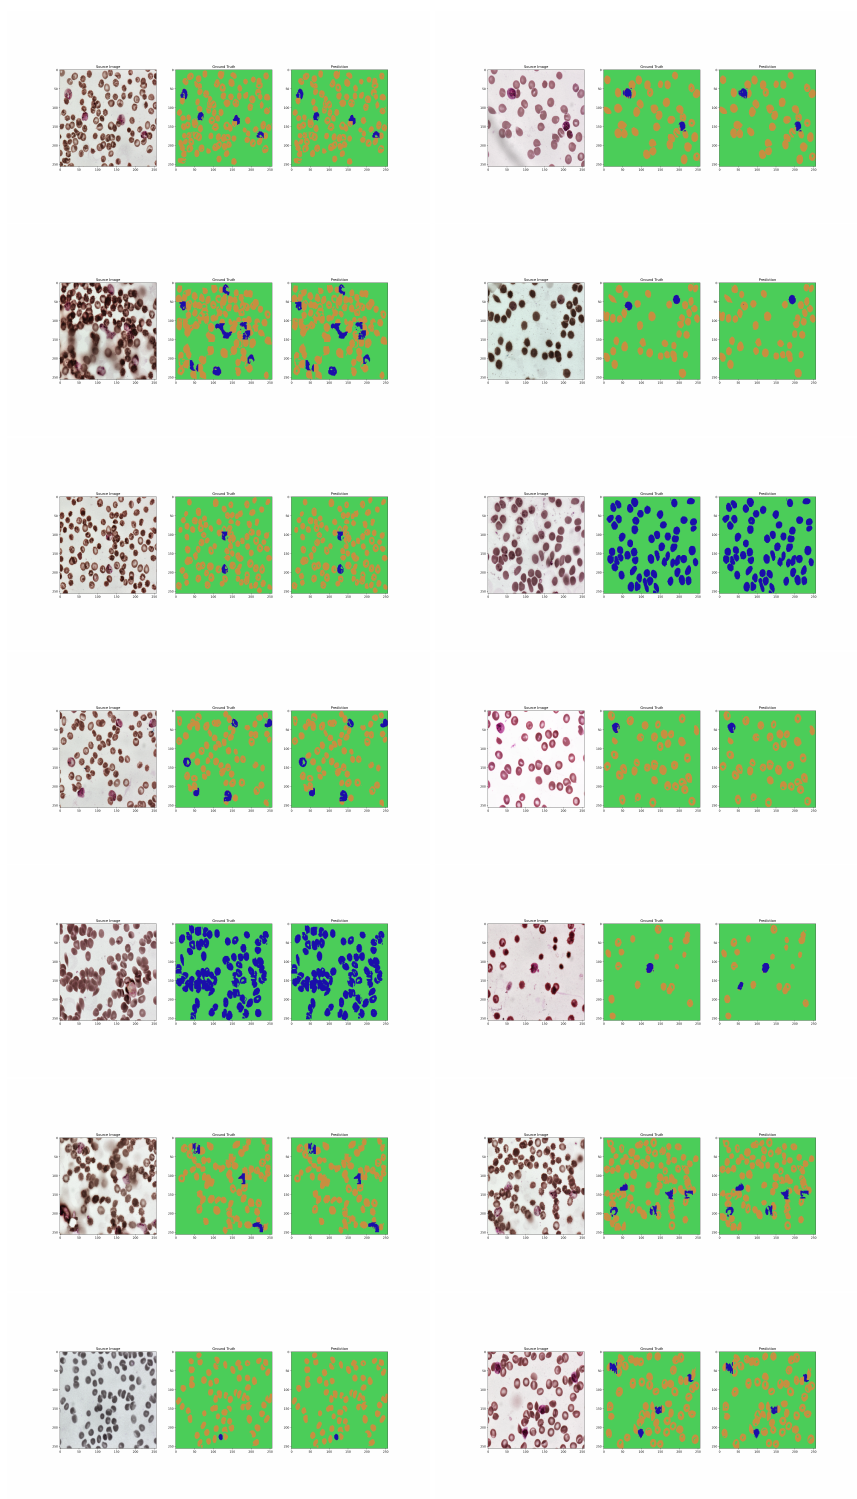
Figure 9. The original samples of the dataset are shown in the first row of the figure. The second and third columns show different types of masks, which are used to highlight certain features or characteristics in the images. The purpose of this evaluation is to assess the performance of the neural network in relation to the original masks. By comparing the output of the neural network with the original masks, it is possible to see how accurately the network is able to identify and classify the different types of cells in the samples. This information can be used to fine-tune the network and improve its performance for future